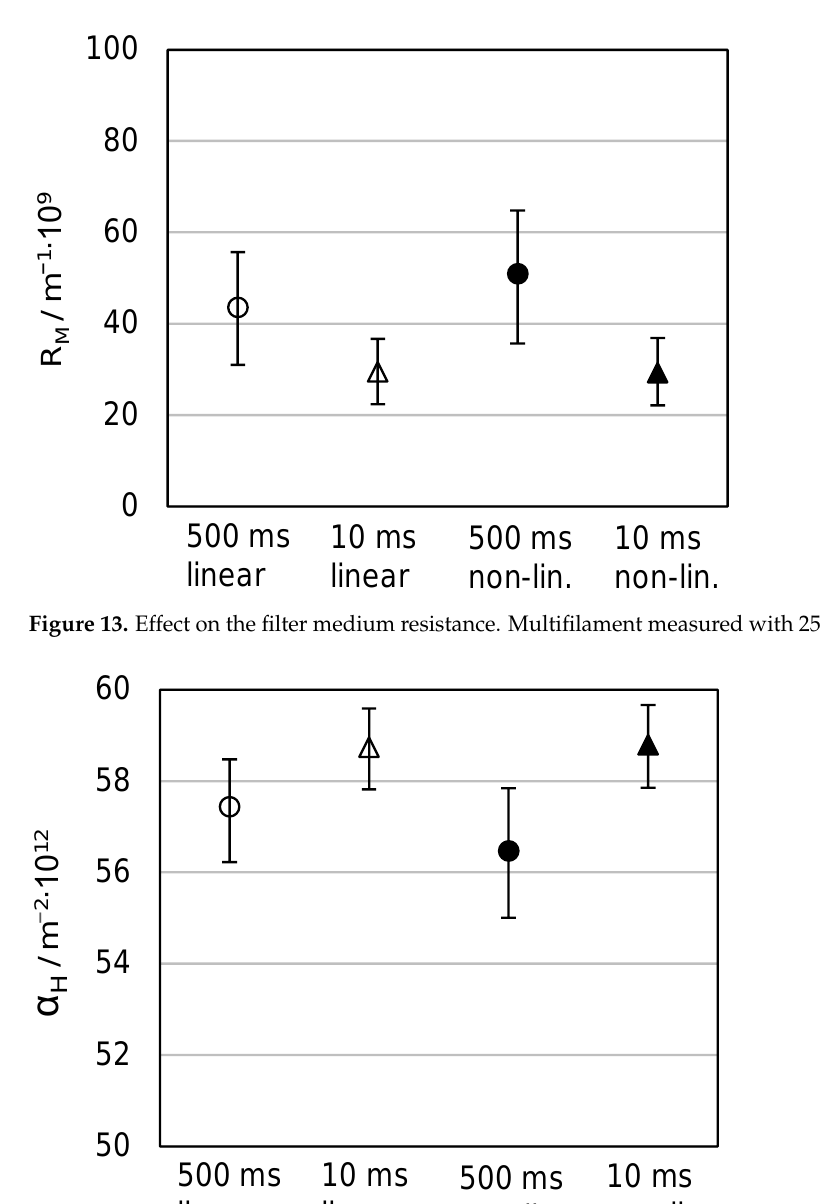
Figure 14. Effect on the filter cake resistance. Multifilament measured with 25 m% PCC at 0.8 bar.